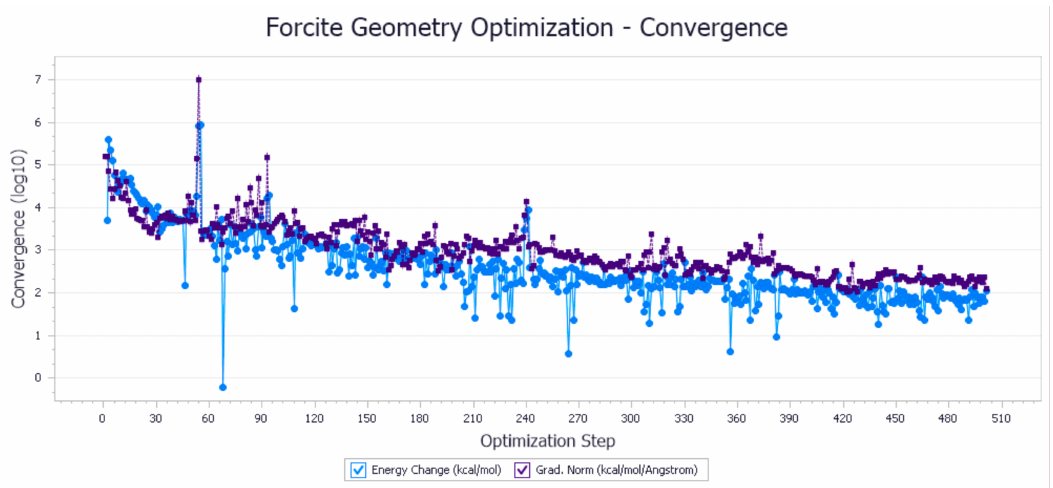
Figure 17. Demulsifier14# oil–water interface geometric optimization steps.